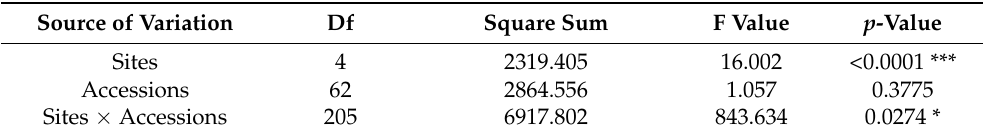
Table 1. ANOVA test of the reported stem rust infection response in the trap nurseries’ accessions under natural disease pressure in field conditions at the five different tested sites in Tunisia during the 2021 cropping